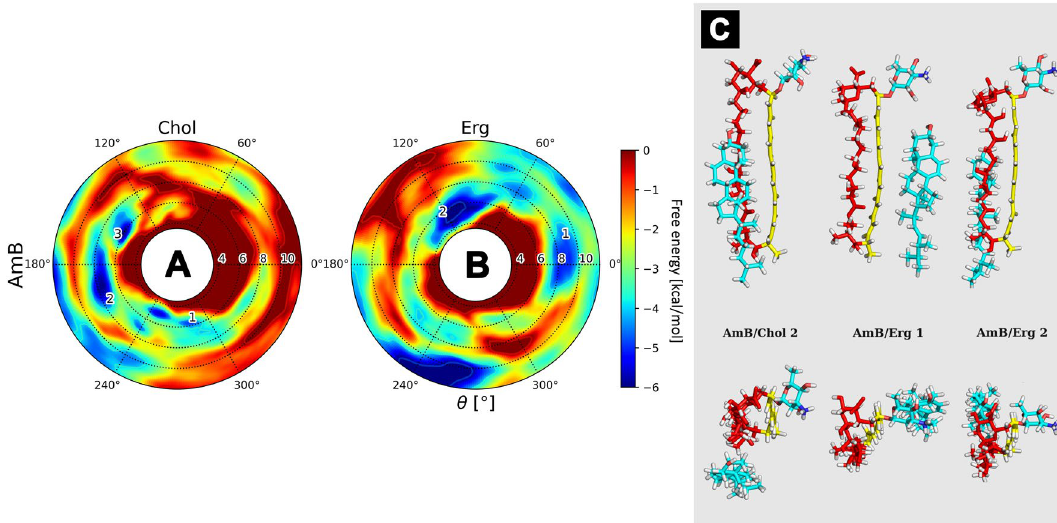
Figure 6. Free energy landscapes, calculated for amphotericin B (panels A & B ). Panel ( C ) contains representative structures of the AmB/sterol complexes, extracted from selected energetic minima via cluster analysis. Number of a structure corresponds to the respective energetic minimum of a given system. Panel ( C ) colours: red—antibiotic’s polyol region; yellow – antibiotic’s heptaene chromophore; light blue—sterol molecule.